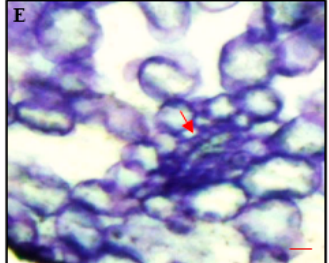
Figure 12. Toluidine blue-stained sections of 14 days old Arabidopsis leaves. ( A ) Wild-type (Col-0) on control media, ( B ) Wild-type (Col-0) treated with PIP on Micro-agar, ( C ) ref3-3 mutant on Micro-agar, ( D ) vascular bundle and cellular organization pattern of normal Wild-type (Col-0) on control media ( E ) hyperhydric ref3-3 mutant leaves on Micro-agar. Bar = 50 µm ( A – C ), 100 µm ( D – E ).